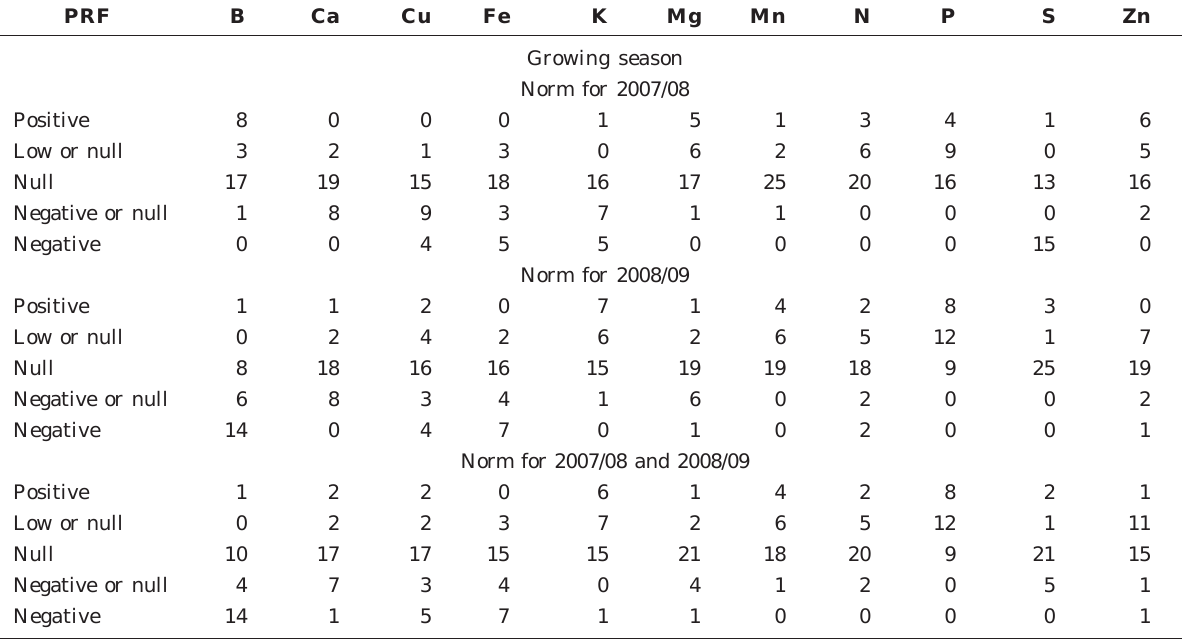
Table 4. Frequency of potential response to fertilization (PRF) (1) for soybean leaf samples (R2 stage) assessed with the DRIS norms obtained from seed oil content in different growing